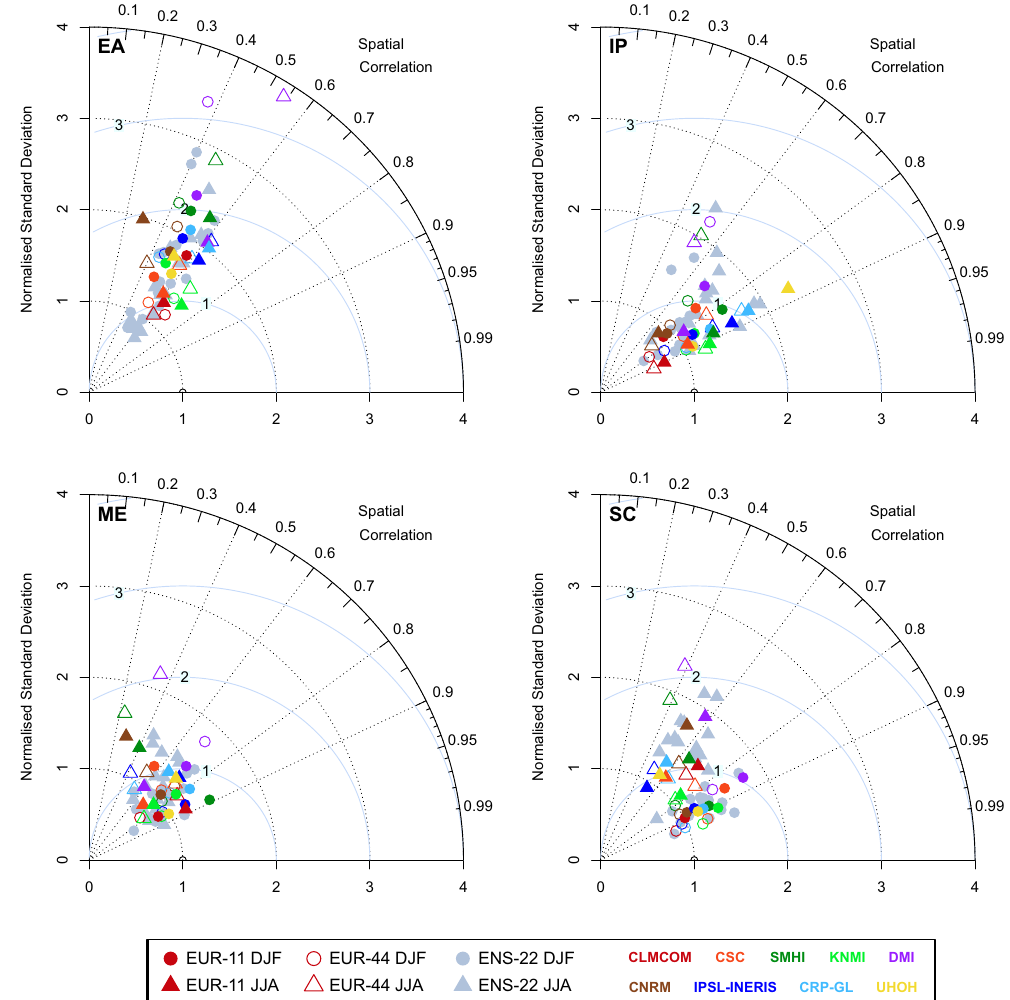
Figure 10. As Fig. 9 but for mean winter (circles) and mean summer (triangles) precipitation. See Fig. B6 for subdomains AL, BI, FR and